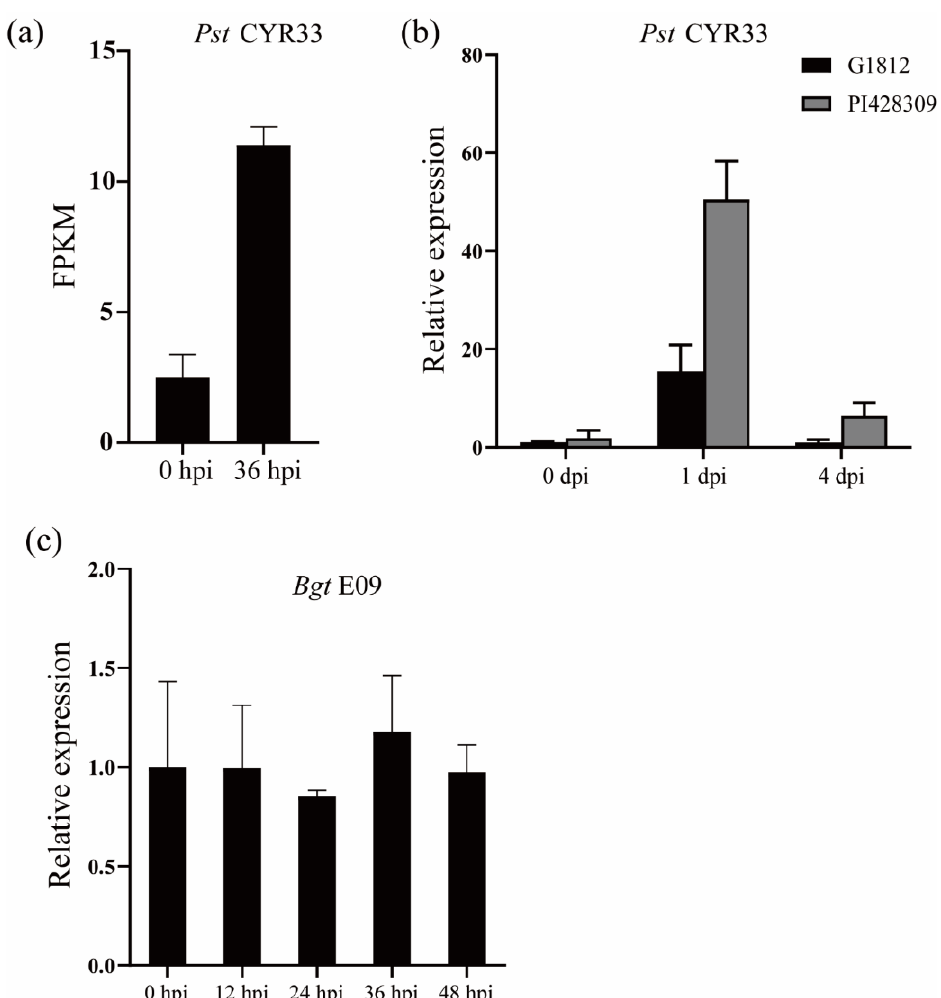
Figure 1. Expression analysis of TuNAC69 in PI428309 and G1812. ( a ) RNA ‐ seq results showed that the expression level of TuNAC69 in PI428309 was significantly up ‐ regulated after inoculation with Pst . ( b ) TuNAC69 was up ‐ regulated in PI428309, and was still maintained at a high level at 4 dpi. ( c ) The expression of TuNAC69 was not significantly changed after inoculation with Bgt E09.